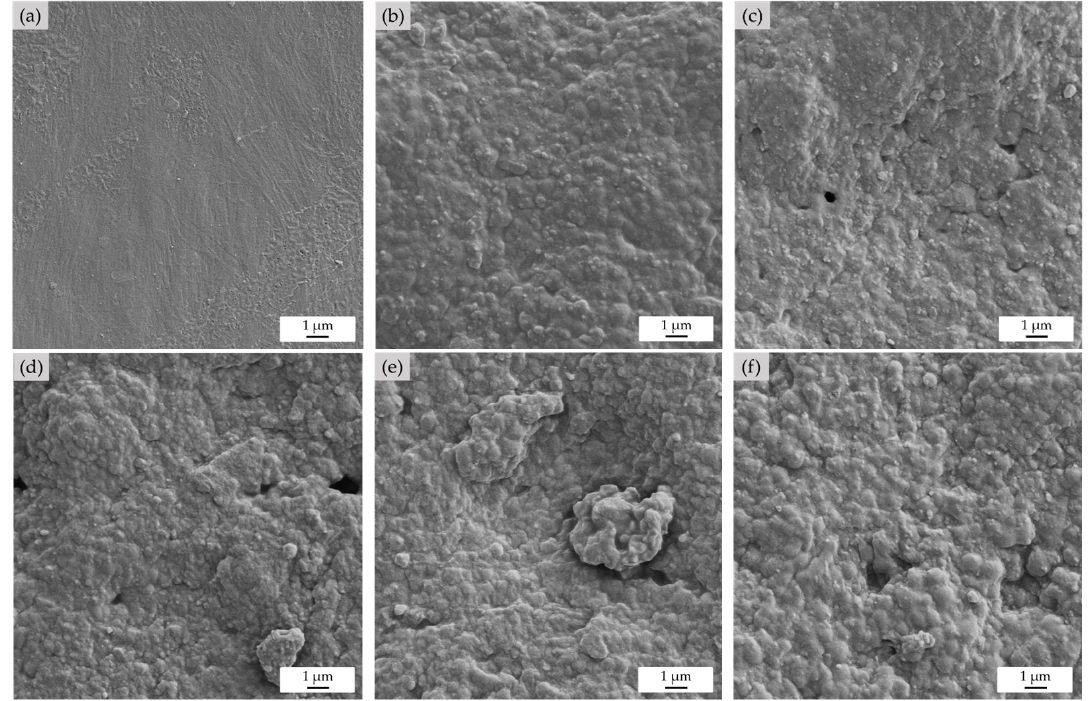
Figure 7. NRL foam composites morphology at the top surface of specimens (5k× magnification): ( a ) EPE-FN; ( b ) NRL-FN-BLF0.0; ( c ) NRL-FN-BLF2.5; ( d ) NRL-FN-BLF5.0; ( e ) NRL-FN-BLF7.5; ( f ) NRL-FN-BLF10.0.